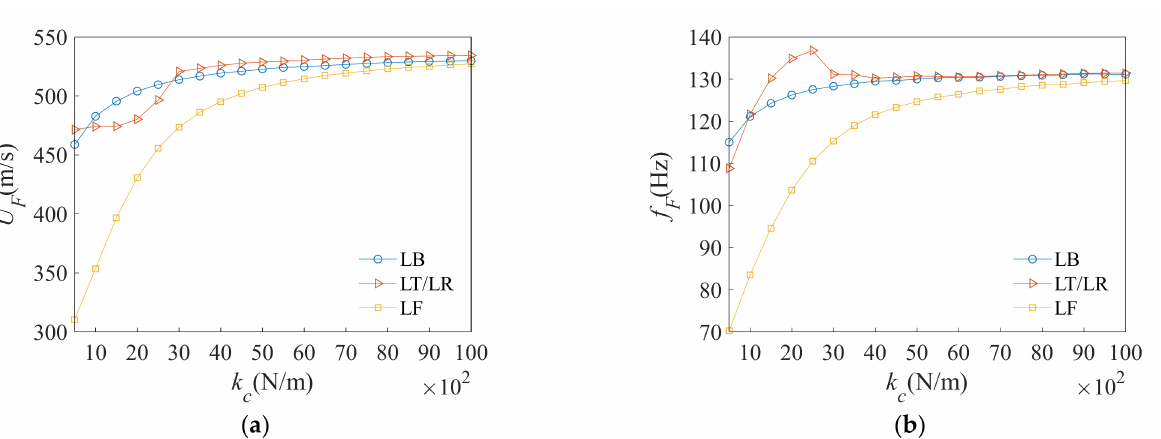
Figure 6. Results of flutter calculation (LF): ( a ) U − g ; ( b ) U − f .